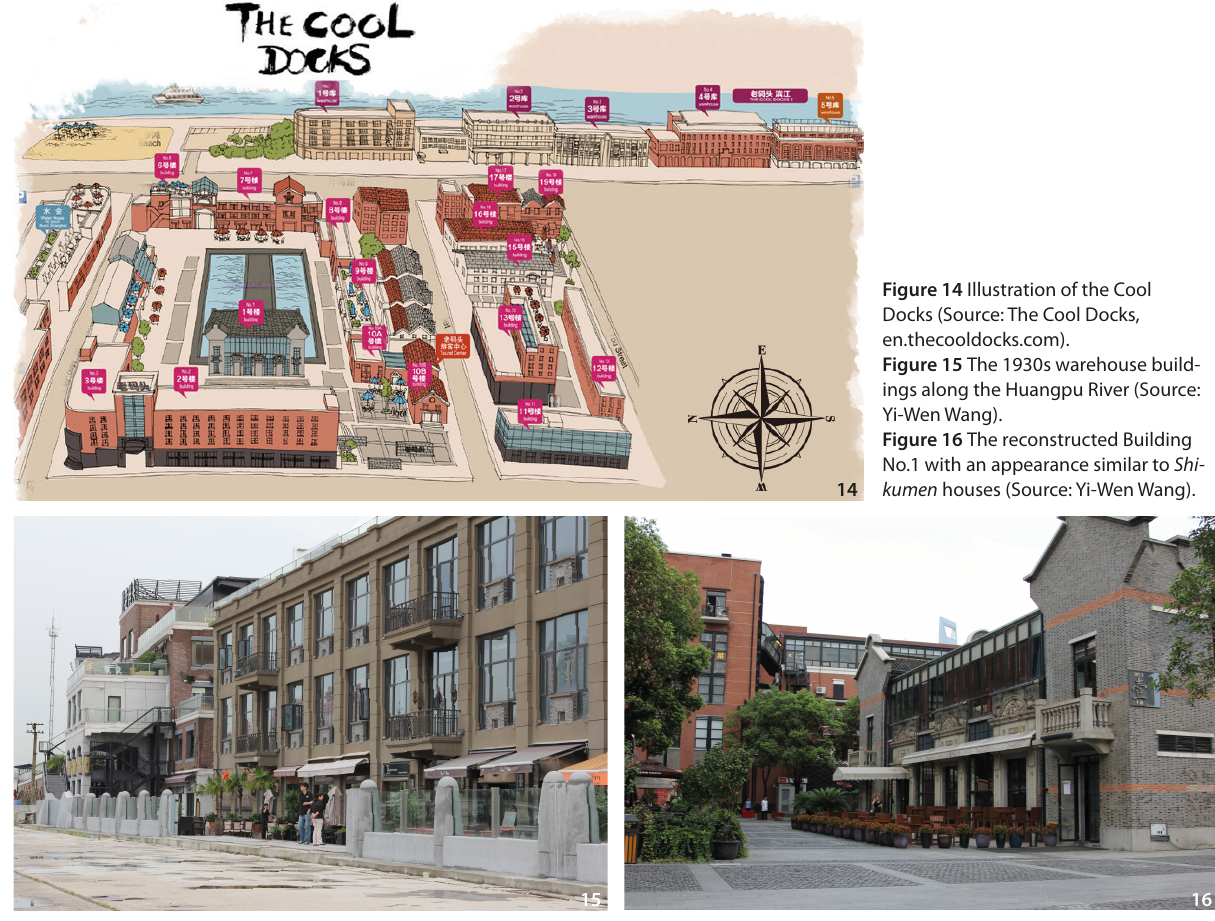
Figure 14 Illustration of the Cool Docks (Source: The Cool Docks, en.thecooldocks.com). Figure 15 The 1930s warehouse build- ings along the Huangpu River (Source: Yi-Wen Wang). Figure 16 The reconstructed Building No.1 with an appearance similar to Shi- kumen houses (Source: Yi-Wen Wang).